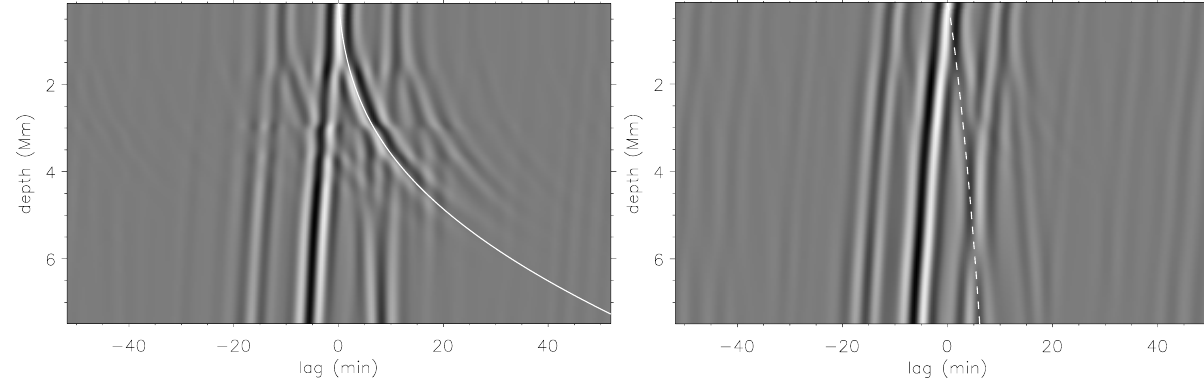
Fig. 4. Simulation cross-correlation in v x (left panel) and v z (right panel) at the centre of the magnetic flux tube as a function of depth. The arriving fast magneto-acoustic wave and reflected slow wave can be seen in the v x cross-correlation, however, the fast wave dominates the v z cross-correlation image. The theoretical time-distance curve for the wave propagating with Alfv´en velocity is overplotted on the left panel (solid white line), and time-distance curve for the wave propagating with local sound speed is overplotted on the right one (dashed